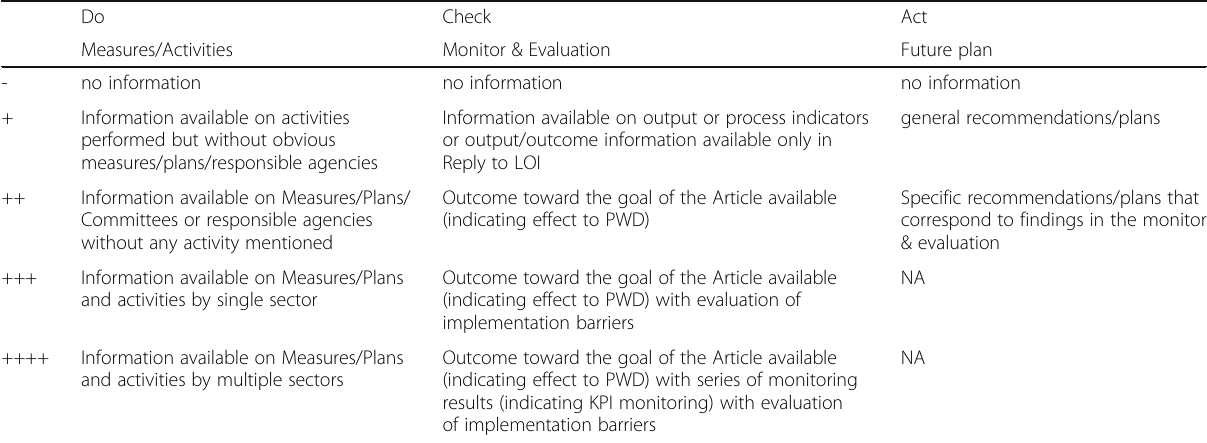
Table 2 Criteria for document evaluation Do Check